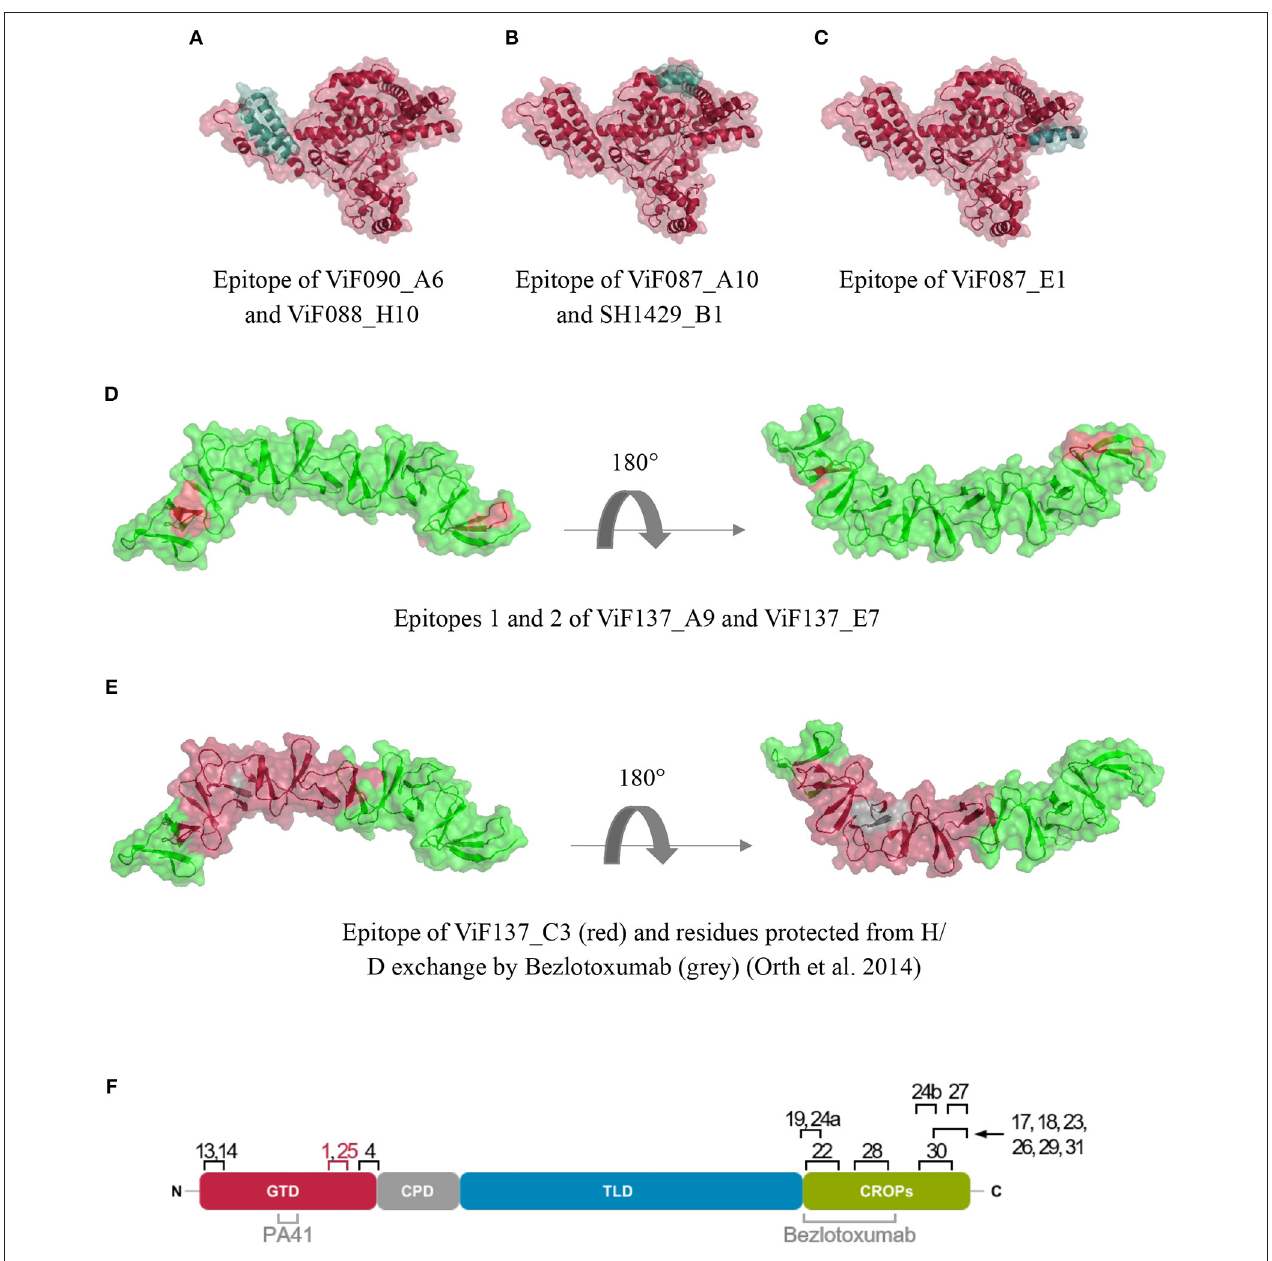
FIGURE 5 | Crystal structures of the glucosyltransferase of TcdB ( A–C , PDB 2bvm), the N-terminal ( D,E PDB 4np4) and C-terminal ( F , PDB 4nc2) fraction of the CROP domain with highlighted epitopes of mapped antibodies. Figures were created using PyMOL (De Lano, 2002) (F) overview over epitopes mapped to TcdB in this study. Neutralizing epitopes are highlighted in red. Neutralizing epitopes published by others are designated in gray (Orth et al., 2014; Kroh et al.,